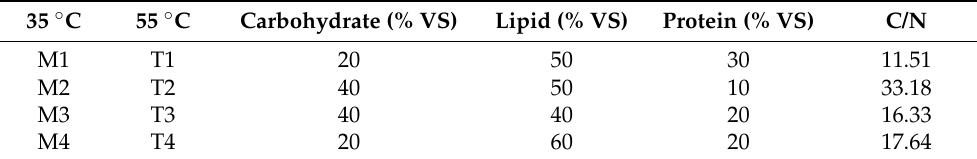
Table 2. Different mixtures of